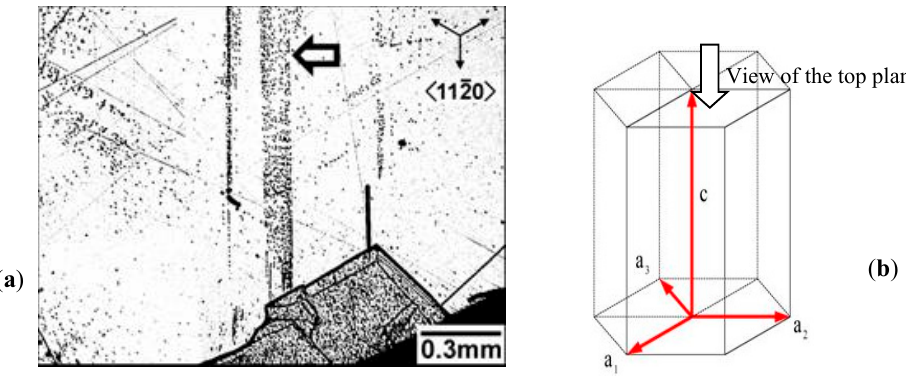
Figure 1. ( a ) Stacking sequence ACAB of 4HSiC crystal: red dots indicate the position of the following atomic layer shown in ( b ) at layers C and B; ( c ) 3D perspective of three initial layers.